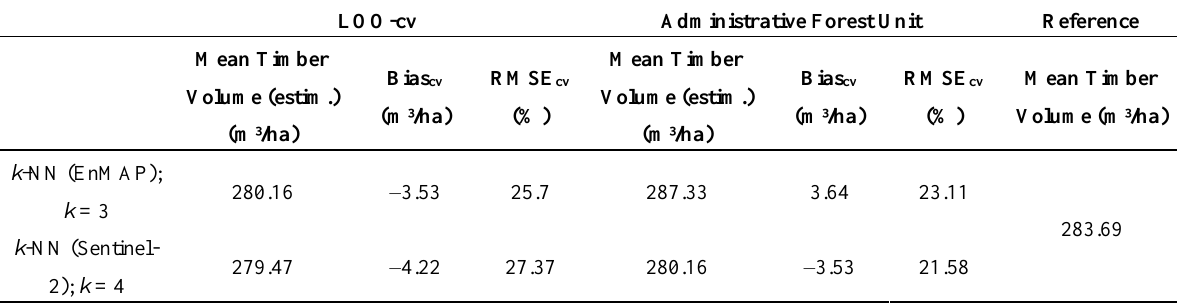
Figure 12 . k -NN-based estimations in comparison to observed values for EnMAP ( a ) and Sentinel-2 ( b ) on the level of administrative forest units. Table 3. RMSE cv , and bias for the optimized k-NN model, based on PC1 and PC3. Validation with loo-cv and for administrative forest